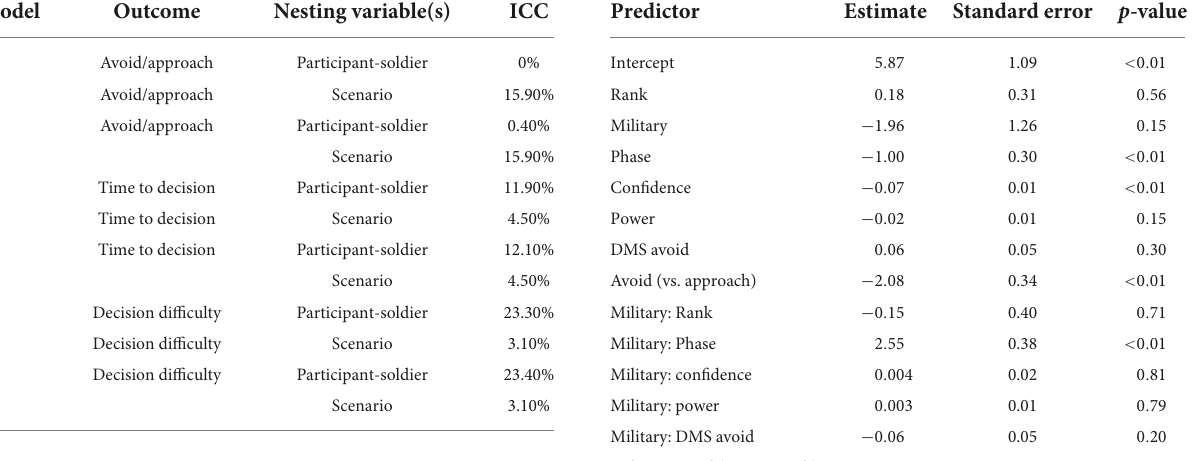
TABLE 2 Predictive model for approach/avoid decisions.